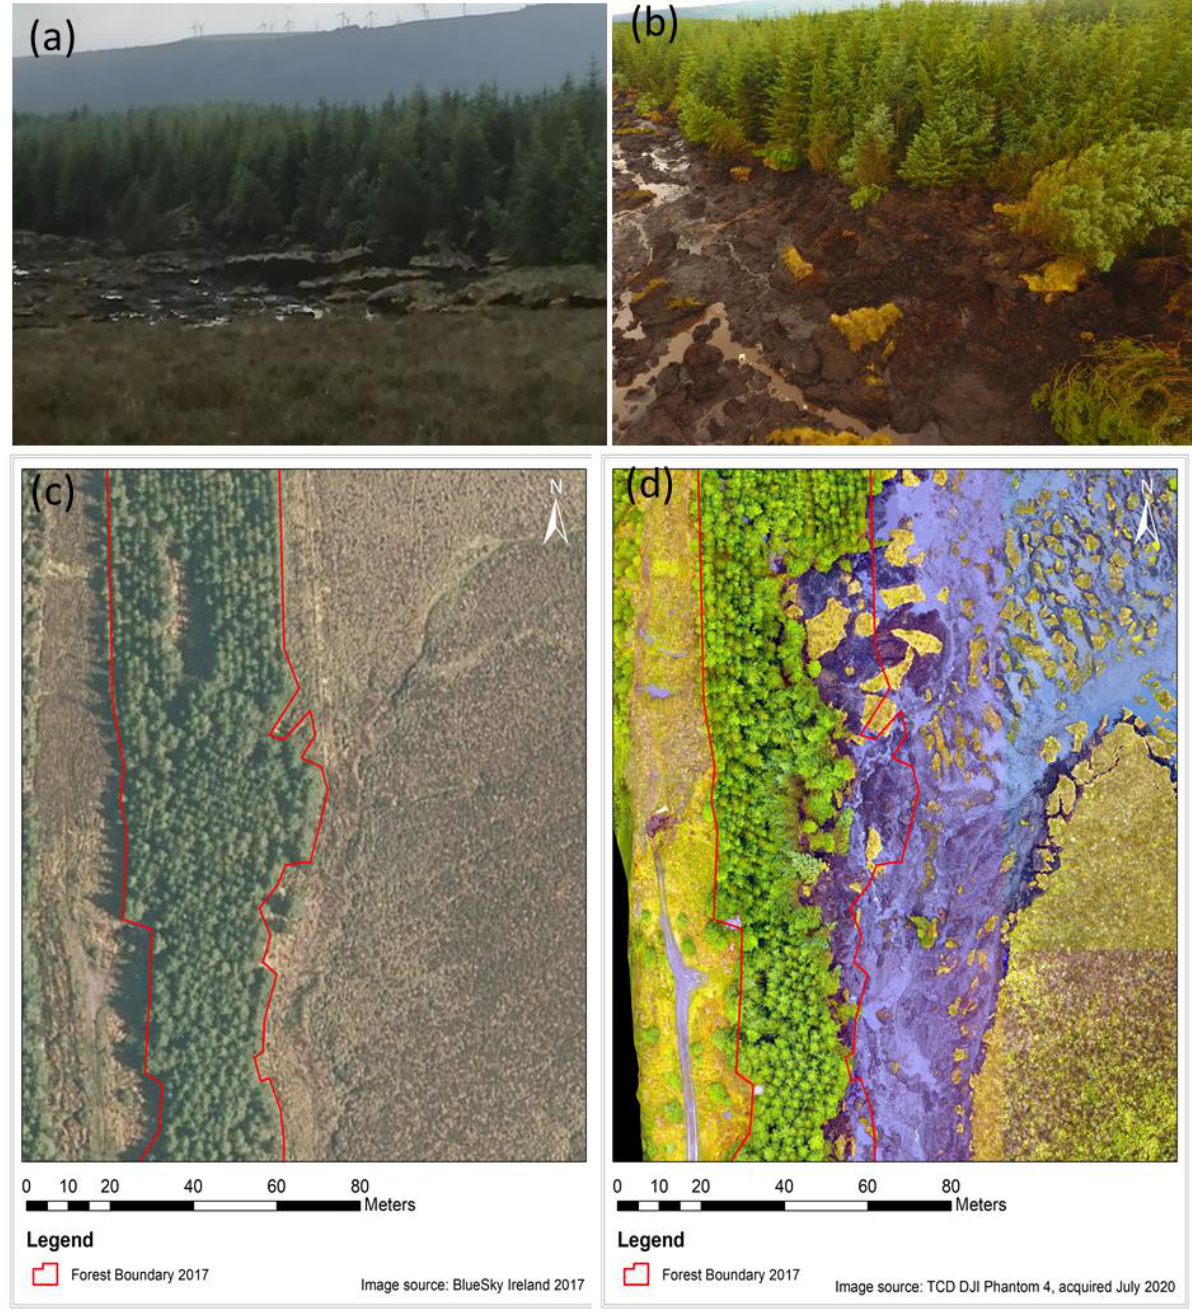
Figure 7. Images of the peat landslide area on Shass Mountain illustrating the impact of the landslide on the forest margin: (a) slabs of peat stack up against the forest edge; (b) trees along the forest edge felled by the force of the landslide; (c) outline of the forest edge before the landslide; (d) outline of the forest edge after the landslide illustrates the extent of the area in which trees were felled by the force of the